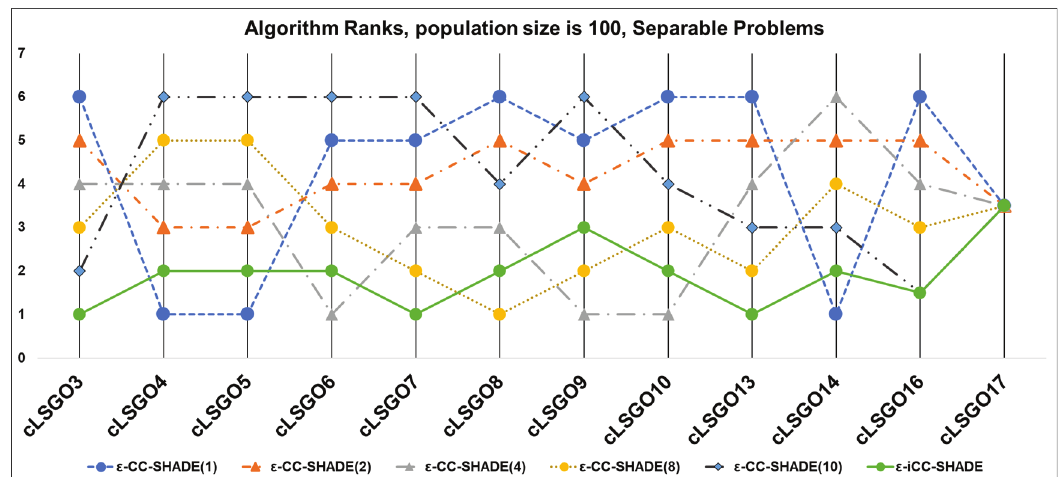
Figure 11. The ranking of ε -CC-SHADE (m) and ε -iCC-SHADE for separable problems.